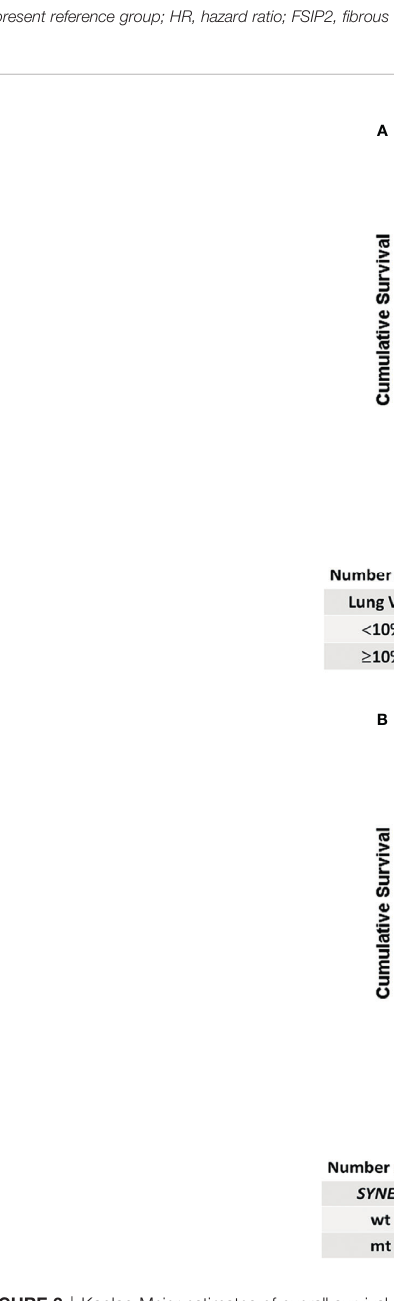
FIGURE 3 | Kaplan-Meier estimates of overall survival. (A) Kaplan-Meier curves for OS according to the factor of ≥ 10% lung volume receiving ≥ 30 Gy (V30). p = 0.006. (B) OS according to the mutation of spectrin repeat containing nuclear envelope protein 1 (SYNE1). p = 0.017. Statistical signi fi cance was determined by Log rank test. OS, overall